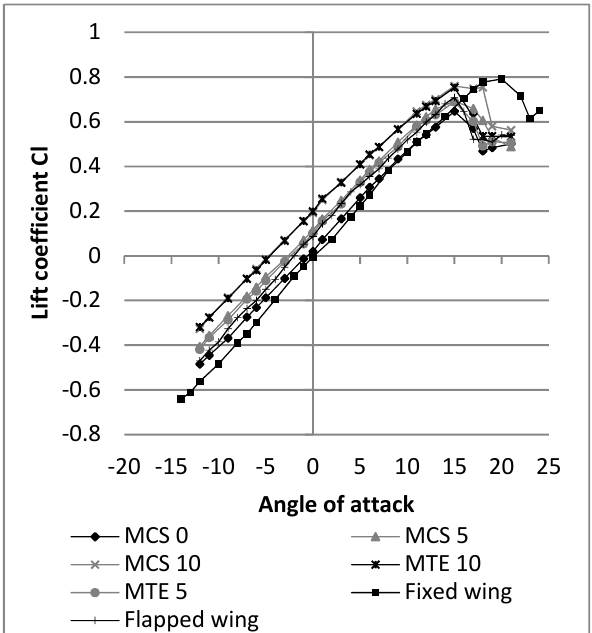
ffi cient variation with angle of Figure 17. Lift coefficient variation with angle of attack. Figure 17. Lift coe Figure 17. Lift coefficient variation with angle of attack.